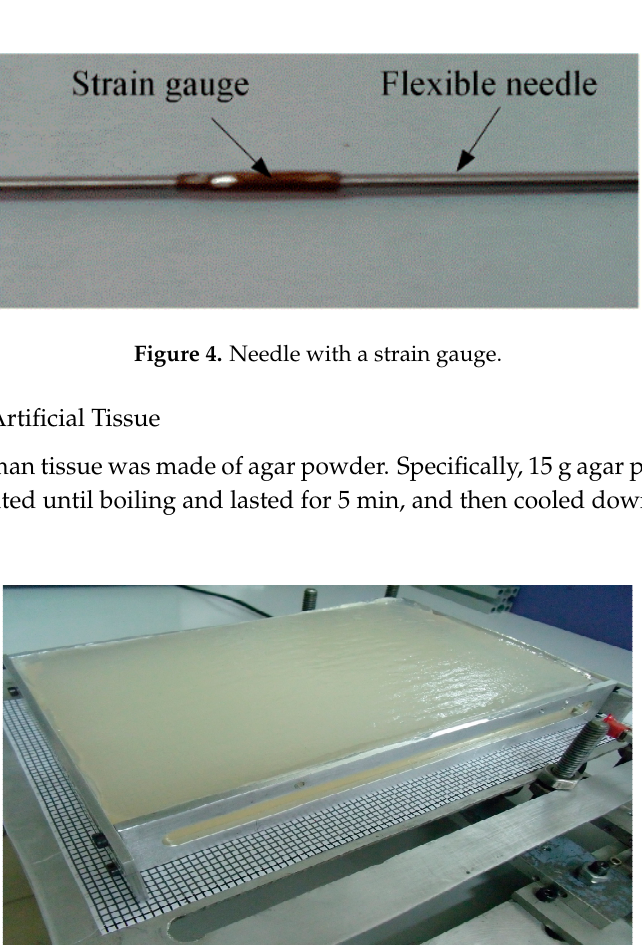
Figure 5. Artificial tissue.